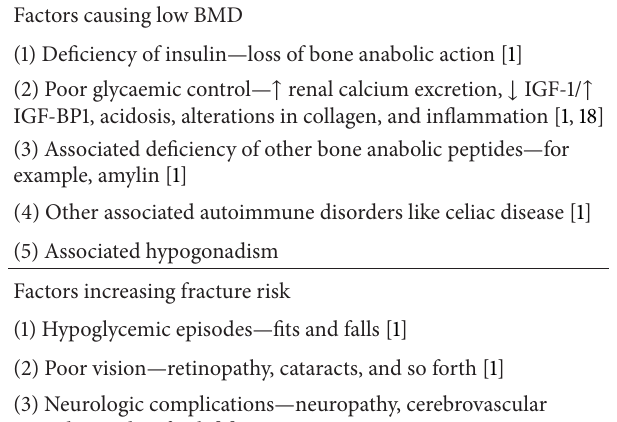
Table 1: Factors implicated in poor bone health and increased frac- ture risk in